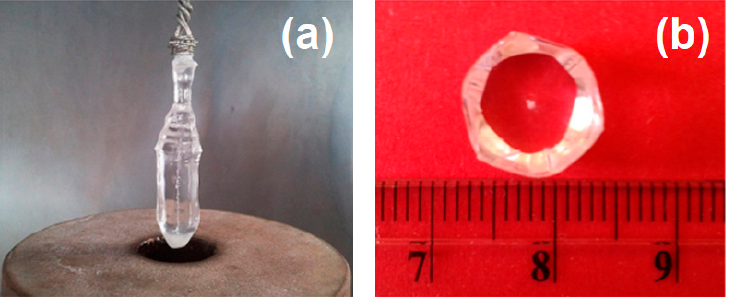
Figure 17. Photo of the as-grown LYSB:Yb crystal ( a ) and the cross-section of the crystal ( b ). Reprinted with permission from ref. [44], copyright 2020, Elsevier.